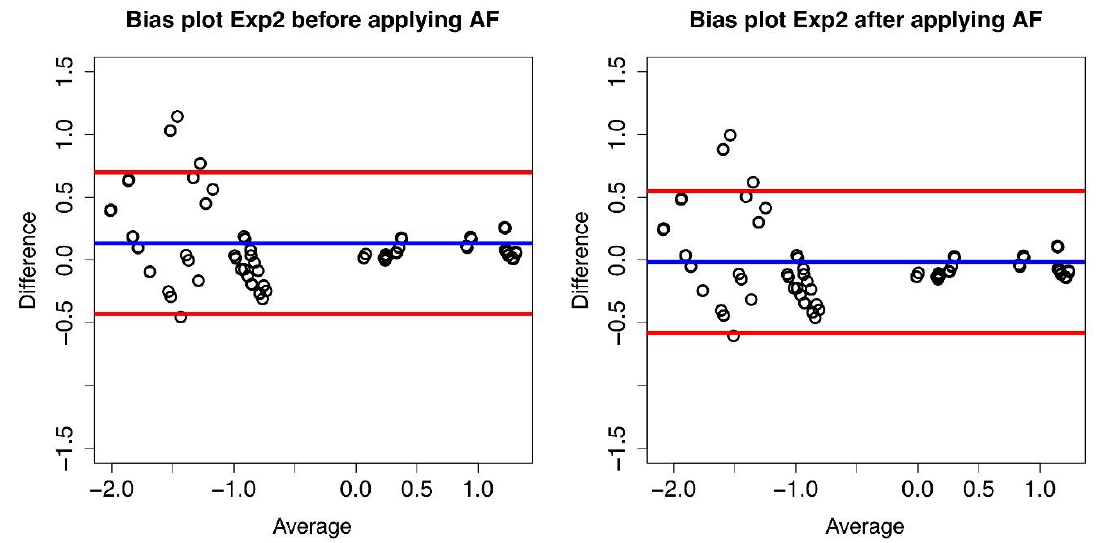
Figure 3. Bias plot of Lab1/Lab2 for Exp2. The difference between the two corresponding datasetsare plotted versus their average value.The blue line represents the mean value of thedifferences (d) (where each difference is defined as log 10 (B) − log 10 (A)), and the red lines define the 95% limits of agreement before conversion (left panel) and after conversion (right panel).